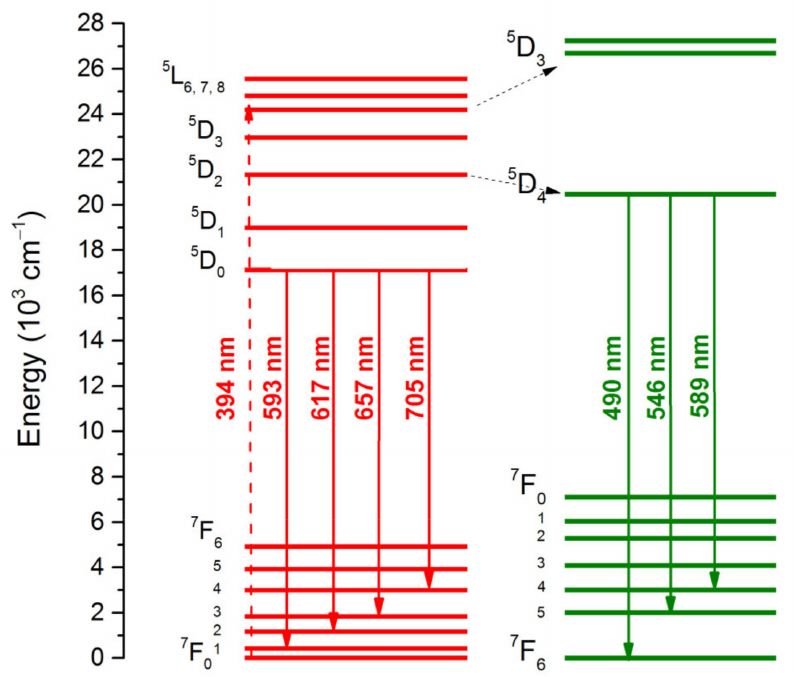
Figure 5. Energy level scheme diagram showing ET from Eu 3+ to Tb 3+ . The decay curves of the Tb 3+ transitions at 490 nm, 546 nm, and 589 nm in CaMo 0.5 W 0.5 O 4 :Eu 3+ x /Tb 3+ 1 − x phosphors were measured under the 256 nm excitation wavelength as represented in Figure 6a–c, respectively. The decay curves of Eu 3+ were also measured under the 256 nm excitation wavelength for the emissions at 617 nm, 656 nm, and 705 nm, which correspond to the 5 D 0 → 7 F 2 , 5 D 0 → 7 F 3 , and 5 D 0 → 7 F 4 transitions, respectively. All curves were fitted by one-exponential decay. To identify and analyze more detailed ET from Eu 3+ to Tb 3+ , we recorded decay curves under λ ex = 394 nm (Figure 6g). The slightly longer lifetime of Tb 3+ ( λ em = 546 nm) and shorter lifetime time of Eu 3+ ( λ em = 617 nm) may indicate energy migration from Eu 3+ to Tb 3+ .